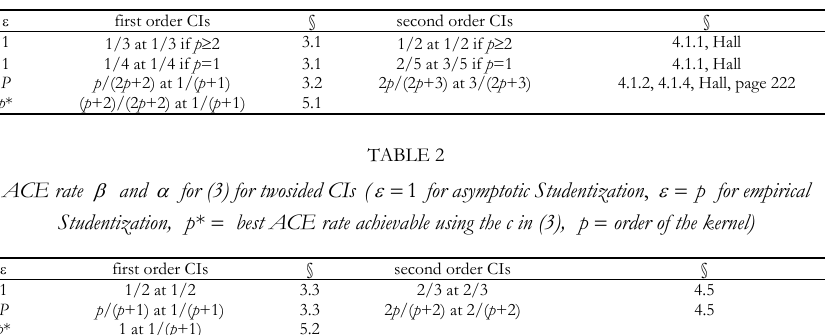
ACE rate β and α for (3) for one-sided CIs 1 ( ε = for asymptotic Studentization , p ε = for empirical